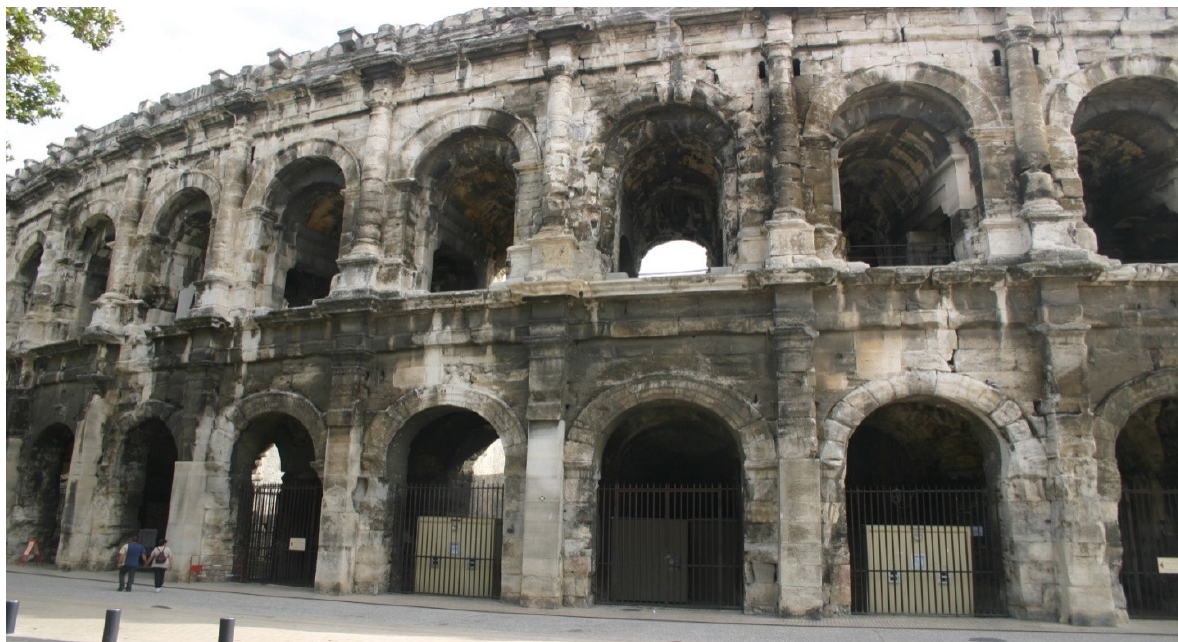
Figure 11. The Maison Carré Roman Temple in central Nîmes.